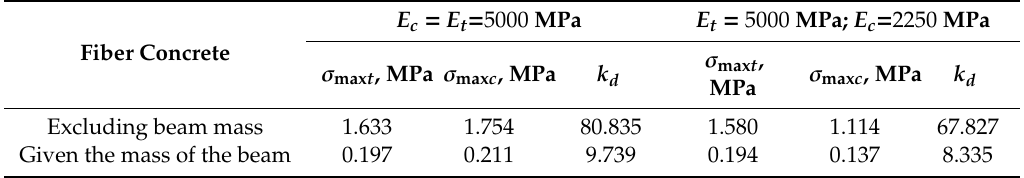
Table 7. The maximum dynamic normal stresses. The bars are located in the stretched and compressed zone.